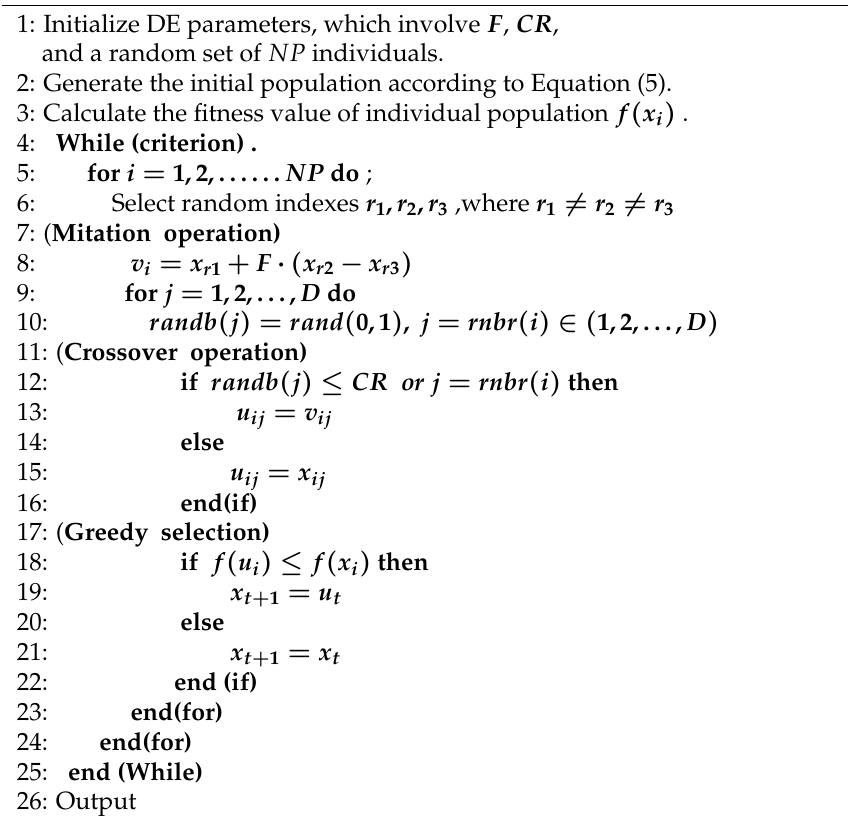
Algorithm 2 The pseudocode of Differential